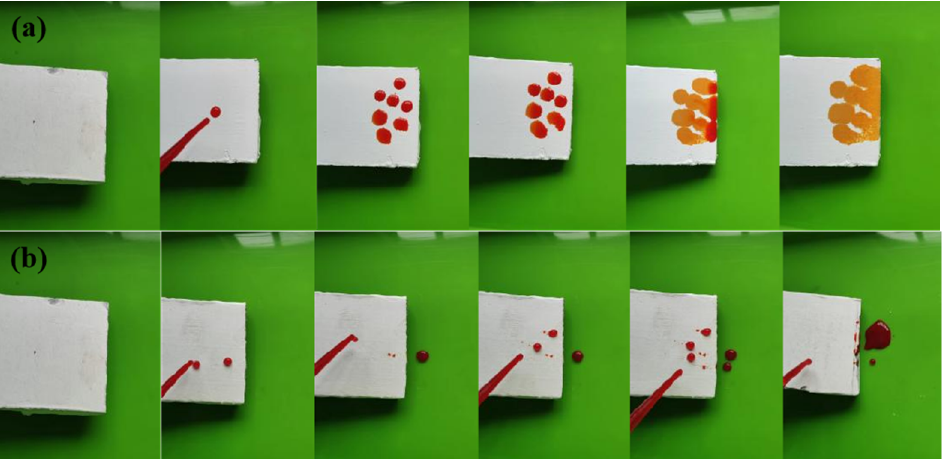
Figure 10. Optical images of liquid contaminants on the surface of building wall samples before and after spraying. ( a ) Liquid pollutants contaminate the uncoated wall surface. ( b ) Liquid pollutants contaminate the coating with n (PDMS): n (TEOS) = 1: 5.